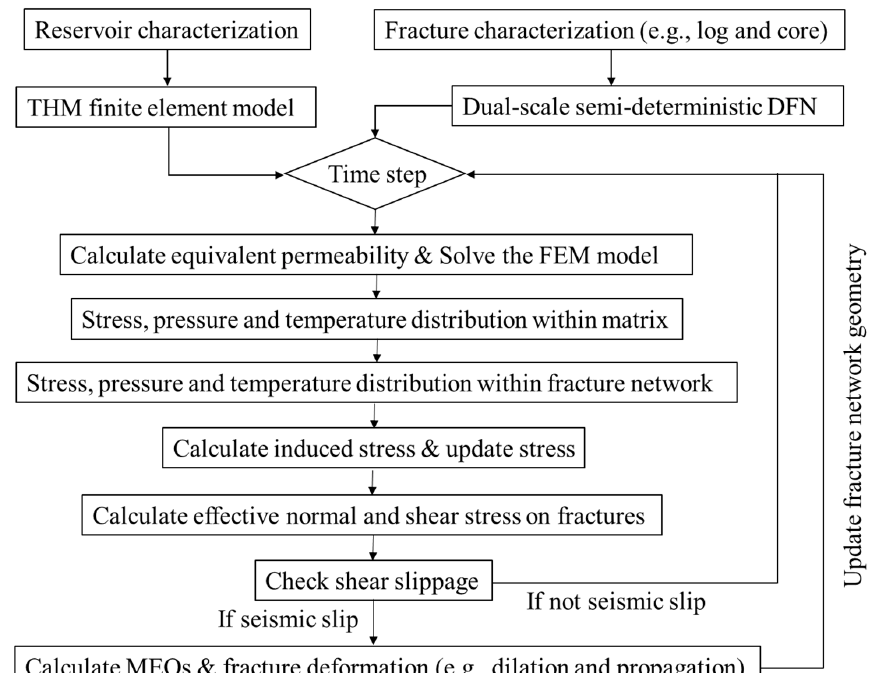
Figure A1. Flowchart of the integrated